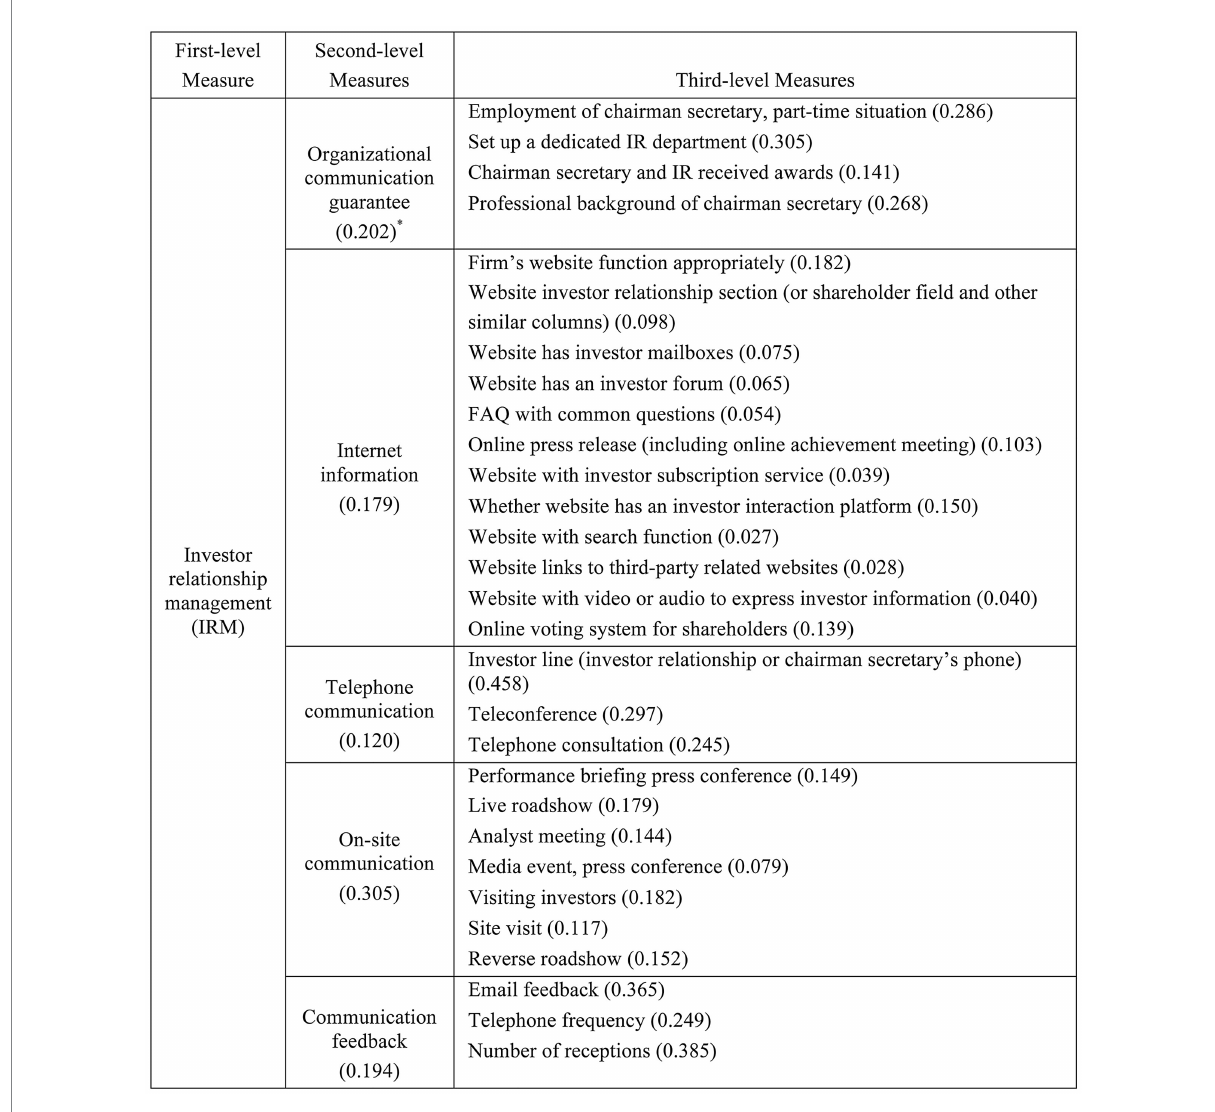
FIGURE 1 Investor relationship management index